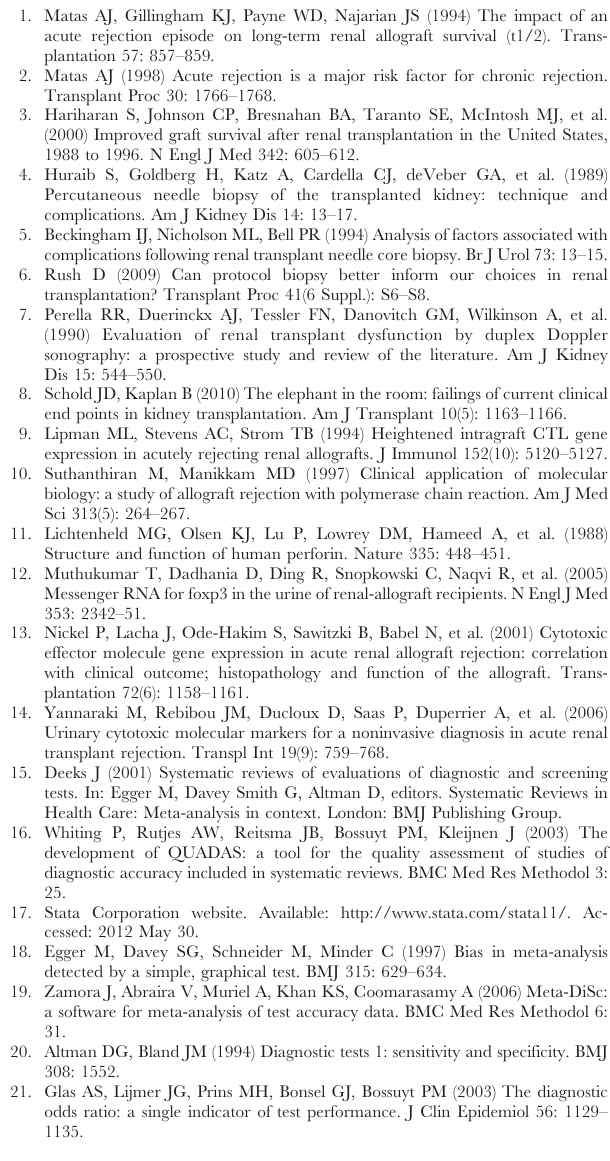
Figure S1 Funnel plot for the assessment of potential publication bias. The funnel graphs plot the log of the DOR against the standard error (SE) of the log of the DOR. Each solid circle represents each study in the meta-analysis. Asymmetry of the circle distribution between two sides indicates potential publication bias. Table S1 PRISMA 2009 check list.